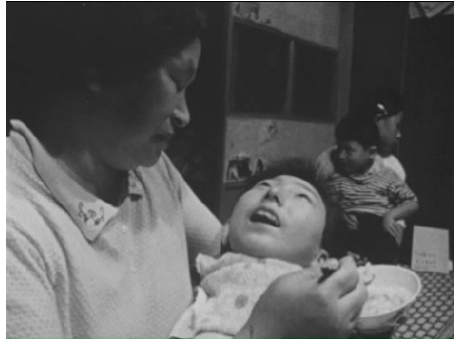
Figure 5. The medium shot of Tomoko. Still from Minamata: The Victims and Their World (1971), director Tsuchimoto Noriaki.